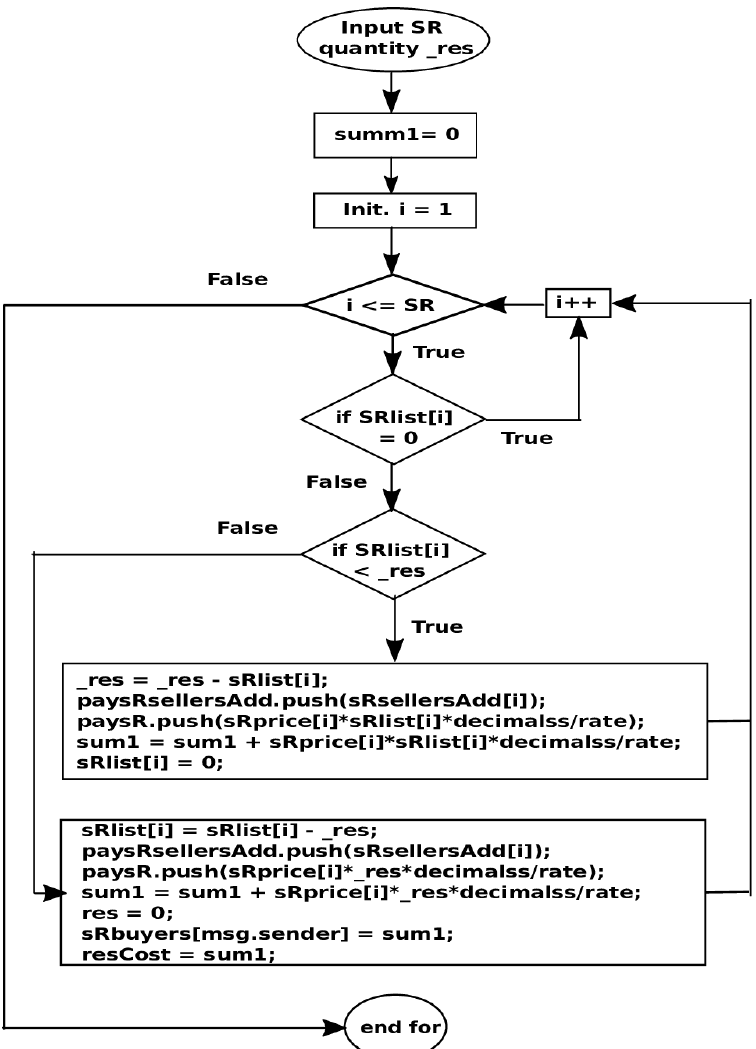
Figure 5. Flowchart of the reserve trading function of the smart contract-enabled spinning reserve trading scheme. It depicts the logic behind the smart contract’s determination of the cost of reserve demanded based on the availability (and offer price) of seller(s) to meet a buyer’s demand. See